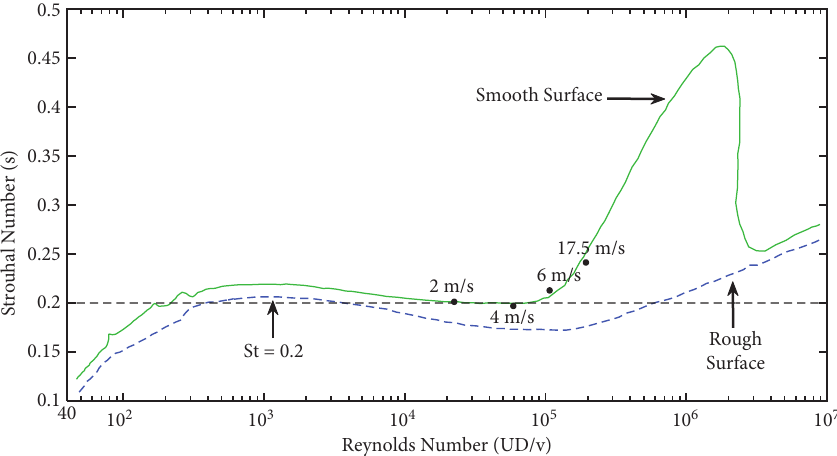
Figure 10: Different Reynolds numbers correspond to Strouhal